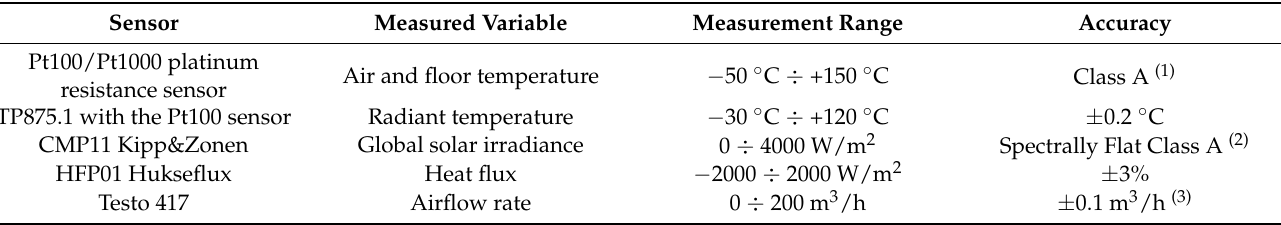
Table 1. The main metrological parameters of the measuring sensors